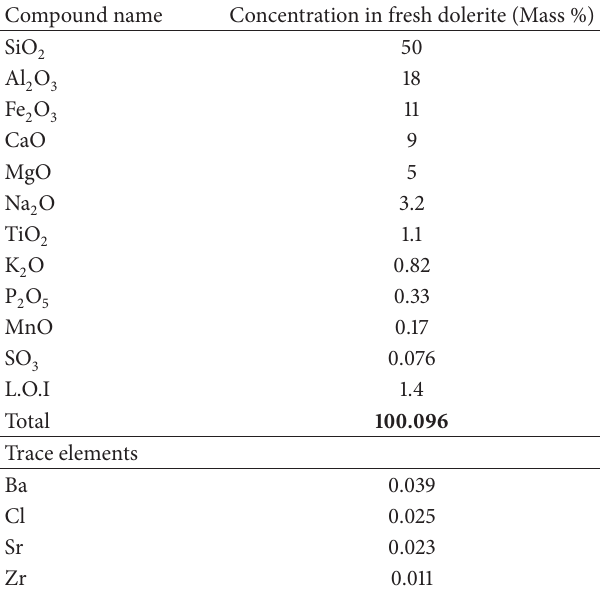
Table 1: Chemical composition of dolerites as determined by XRF.